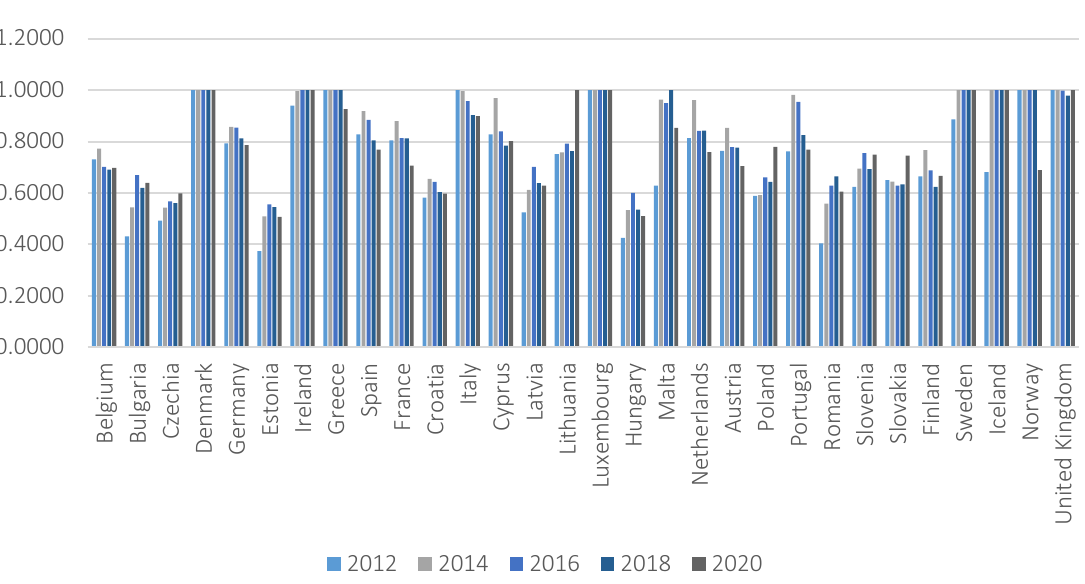
Figure 4. Estimated bi-annual values of TFEE,